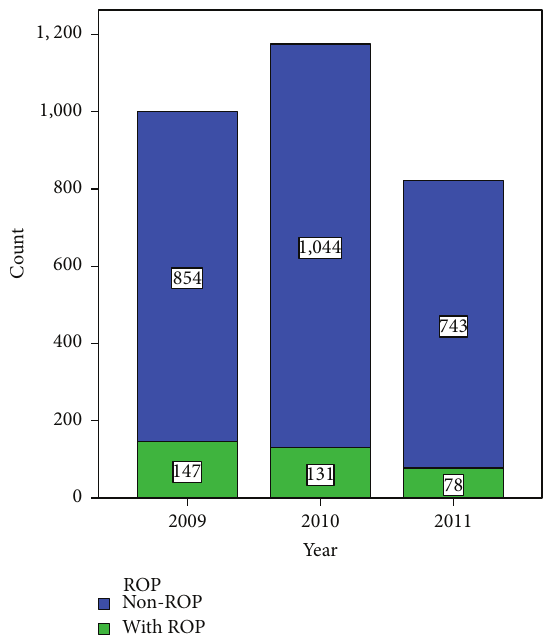
Figure 1: The number of ROP infants and ROP incidence in 2009, 2010, and